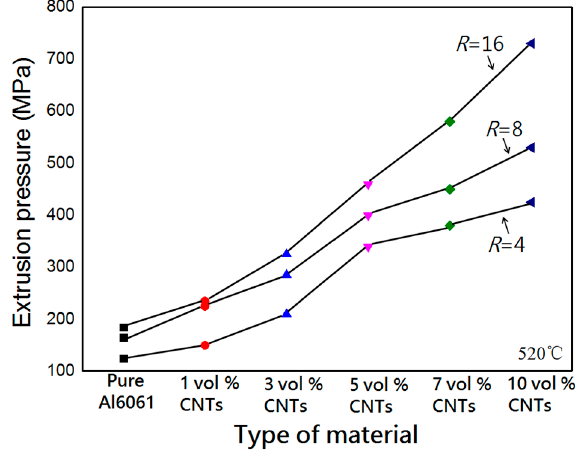
Figure 7. Extrusion pressure according to extrusion ratio and CNT content.